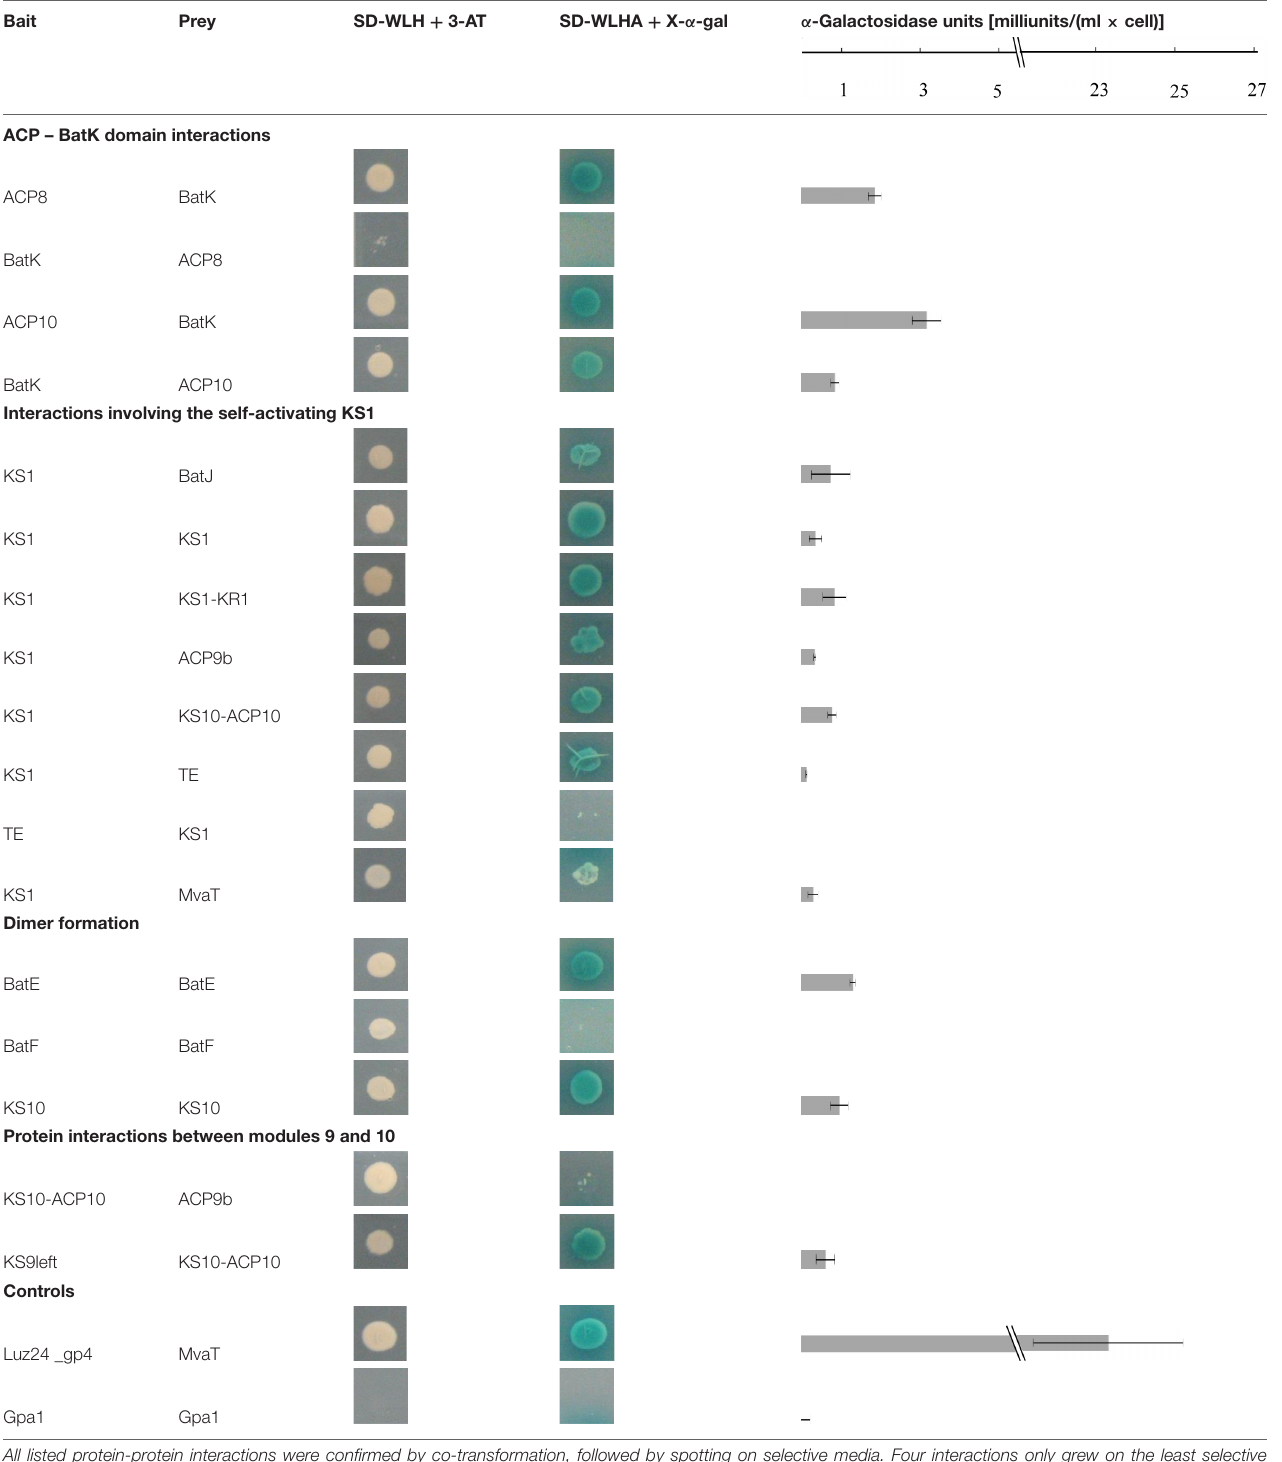
TABLE 1 | Confirmed interactions observed in the pooled array-based Y2H. Bait Prey SD-WLH + 3-AT SD-WLHA + X- α